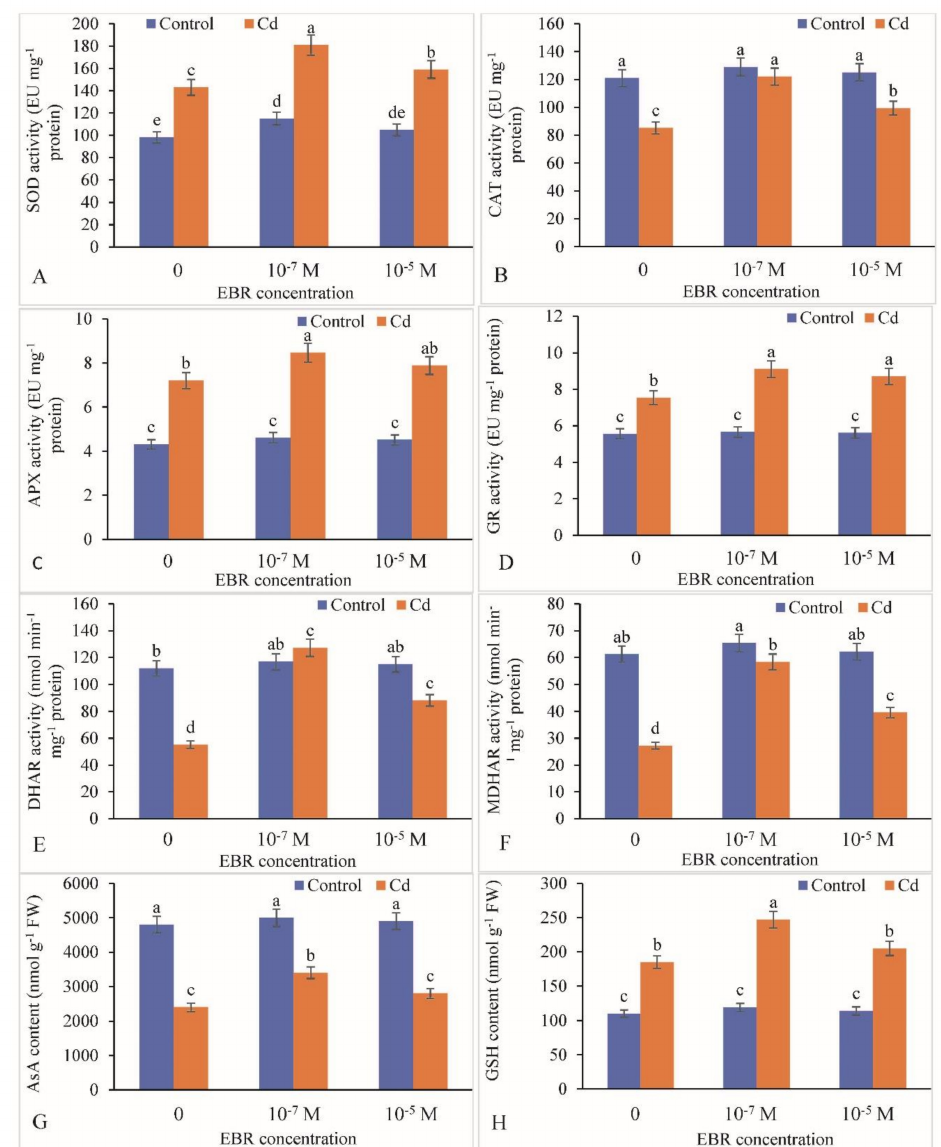
Figure 7. Supplementation of 24-Epibrassinolide enhanced the activity of leaf ( A ) SOD, ( B ) CAT, ( C ) APX, ( D ) GR, ( E ) DHAR, ( F ) MDHAR, ( G ) AsA content and ( H ) GSH content in B. juncea under Cd (200 µ M) stress. Values with di ff erent letters above the bars are significantly di ff erent at each measured time point ( p < 0.05) (Mean ±